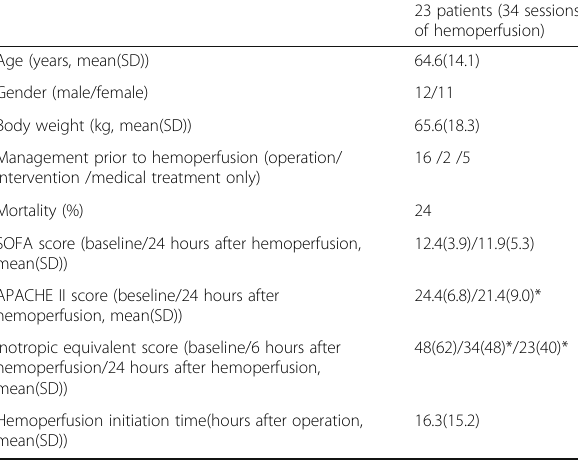
Table 118 (abstract A383). Patient Characteristics and Outcomes